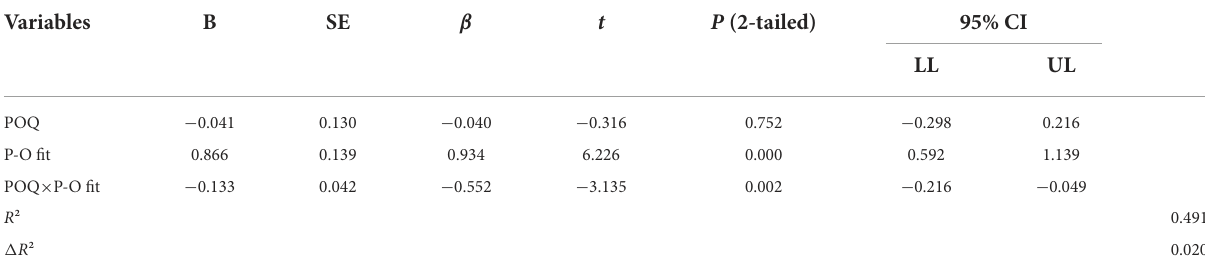
TABLE 7 Overall summary of moderation effects.